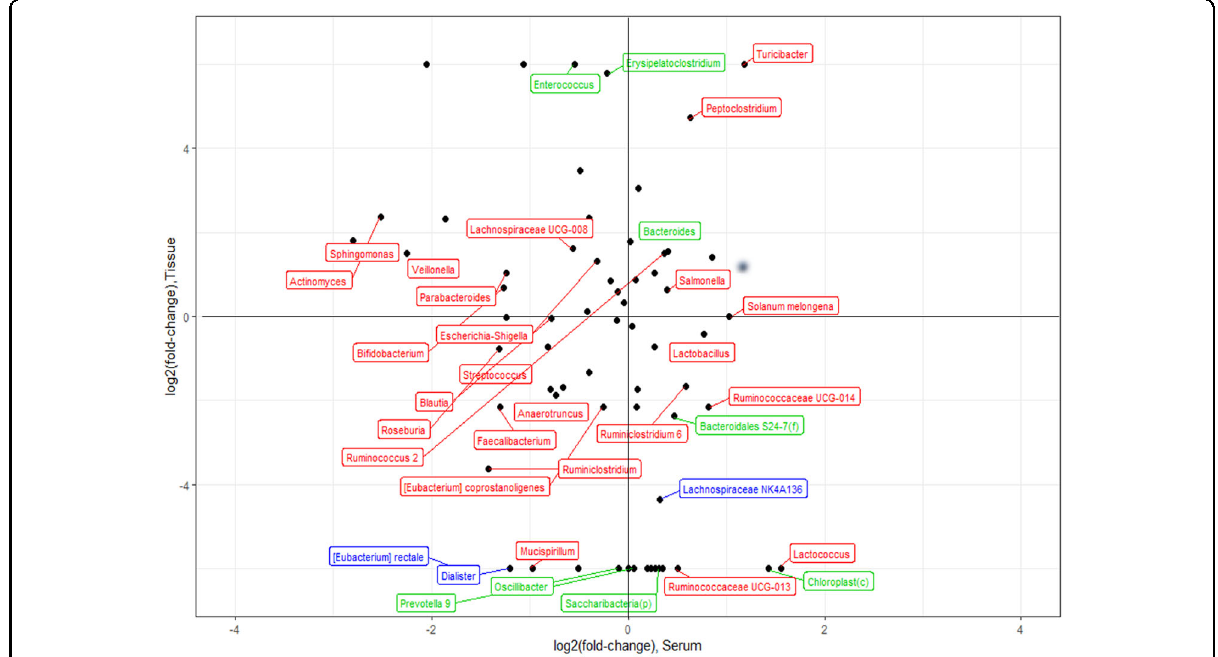
Fig. 6 Fold-change between healthy control (HC) subjects and brain tumor (BT) patients in serum and tissue at the genus level. Red indicates genera of microbial EVs that were signi fi cantly different between the clinical groups in serum, while green represents those that were signi fi cant in tissue. Blue data points indicate microbial EV genera with signi fi cant differences in both serum and tissue samples.